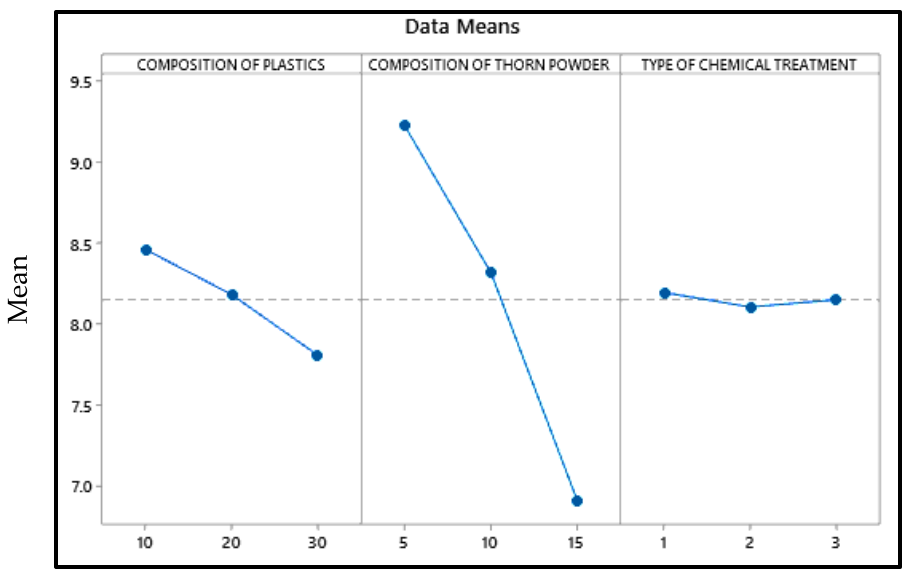
Figure 14. Main effect plot for minimum wear rate.